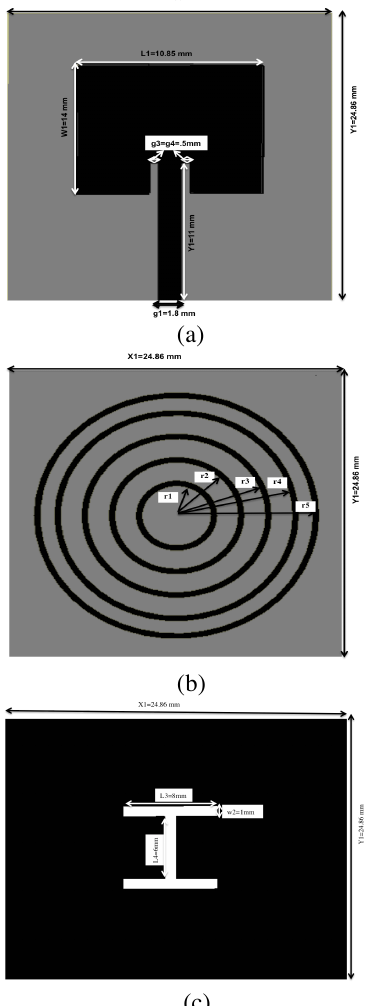
Figure 2: a) Micostrip Antenna b) Concentric Rings c)I Shape